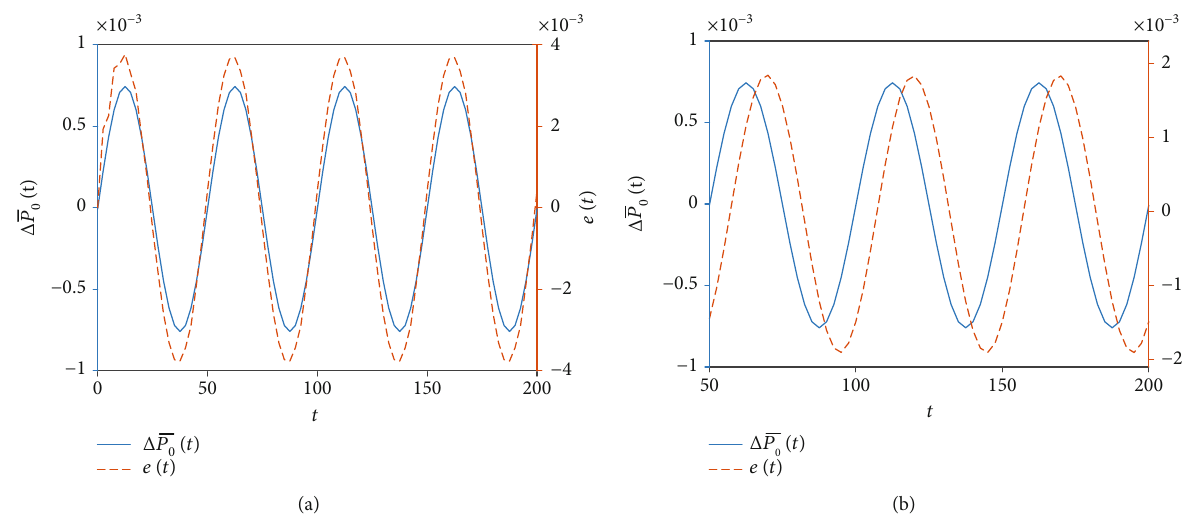
(cid:1) ð t Þ (solid line on y -axis) and strain response e ð t Þ parameter on system response; sinusoidal pressure input Δ P def 0 j = 0 : 2600 , ϵ = 0 : 1750 , and f = 0 : 02 . = 10 and (b) L = 1 , at j (cid:1) ρ def def 0